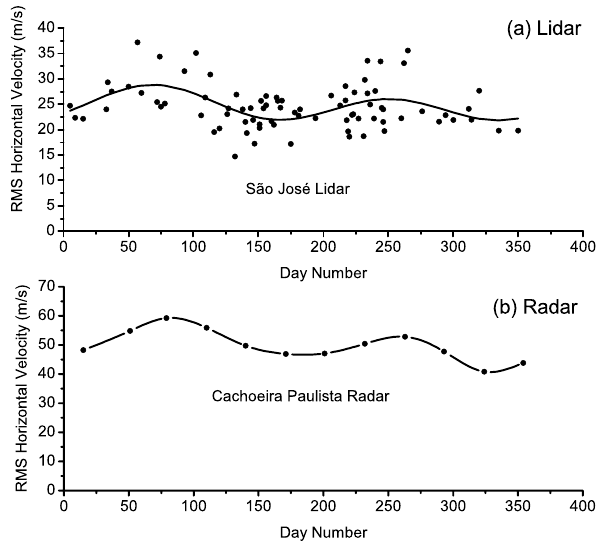
Fig. 2. (a) Fluctuating wind velocities derived from sodium lidar measurements; (b) Monthly mean height-integrated fluctuating ve- locities for Cachoeira